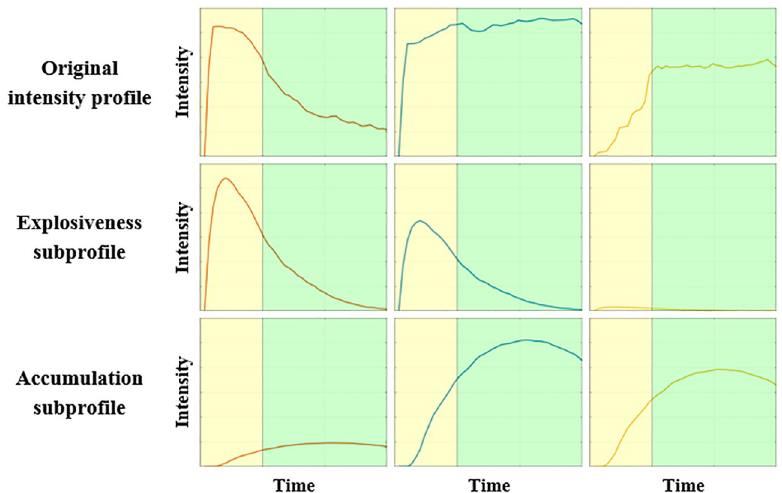
Fig 3. Original drawings (upper panel), explosiveness subprofiles (middle panel) and accumulation subprofiles (lower panel). Adding the reconstructed subprofiles closely approximates the original intensity profile. Yellow (left) and green (right) backgrounds correspond to reading and thinking about the feedback,